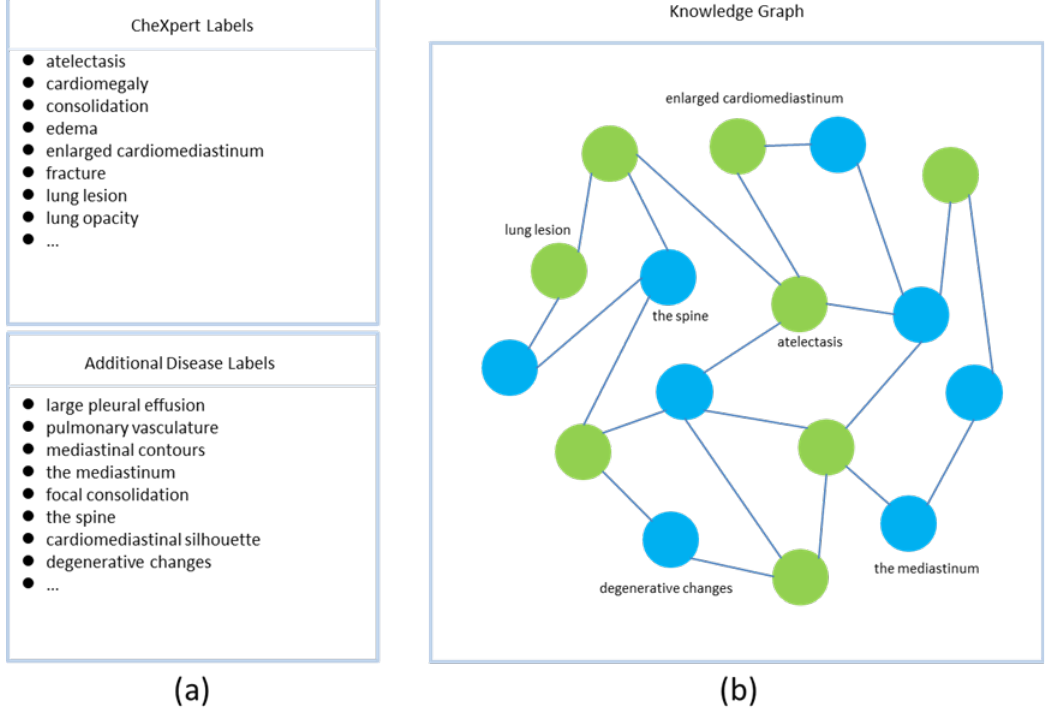
Figure 2. Construction of the knowledge graph. The knowledge graph is built based on the co-occurrence of the tags in the radiology report, and only the tag names of some nodes are shown. In the figure, part ( a ) represents all node names in the knowledge graph; part ( b ) represents the knowledge graph, where the green nodes represent the 14 common disease labels defined by CheXpert, and the blue nodes represent the additional disease labels defined by us.